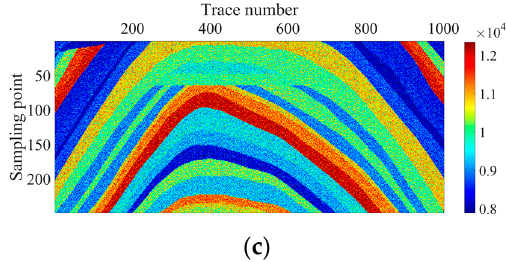
Figure 2. The inversion results. ( a ) GMHDD; ( b ) GMH and ( c ) UMH.